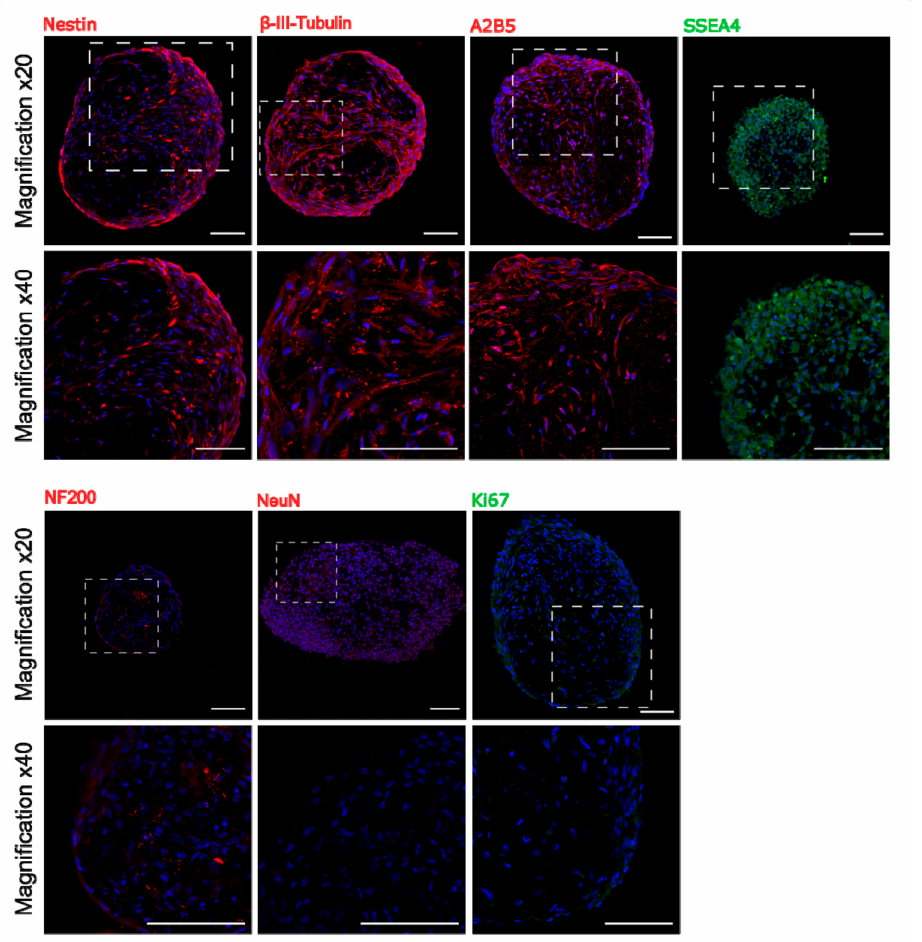
Figure 4. Immunocytochemistry staining of neural and pluripotent markers in sectioned WJ-MSC spheroids in two different magnifications. Early neural markers are also expressed inside the sphere, whereas more mature neural markers were not detected. Spheroids were collected between 10 and 20 day in vitro of 3D culture. Scale bars: 100 µ